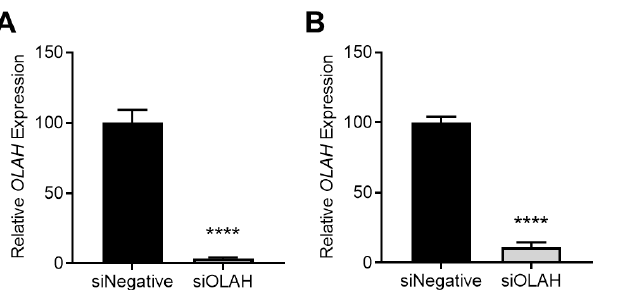
Figure 5. Knockdown of OLAH in cytotrophoblast cells under ( A ) normoxic and ( B ) hypoxic condi- tions. OLAH mRNA expression was significantly reduced with addition of siRNAs in both normoxic (8% O 2 ) and hypoxic conditions (1% O 2 ), assessed via qPCR. Data presented as relative mean ± SEM. n = 3. **** p < 0.0001. Levels of anti-angiogenic factor sFLT1 are elevated, and angiogenic factor PGF are reduced in the circulation of individuals whose pregnancies are complicated by